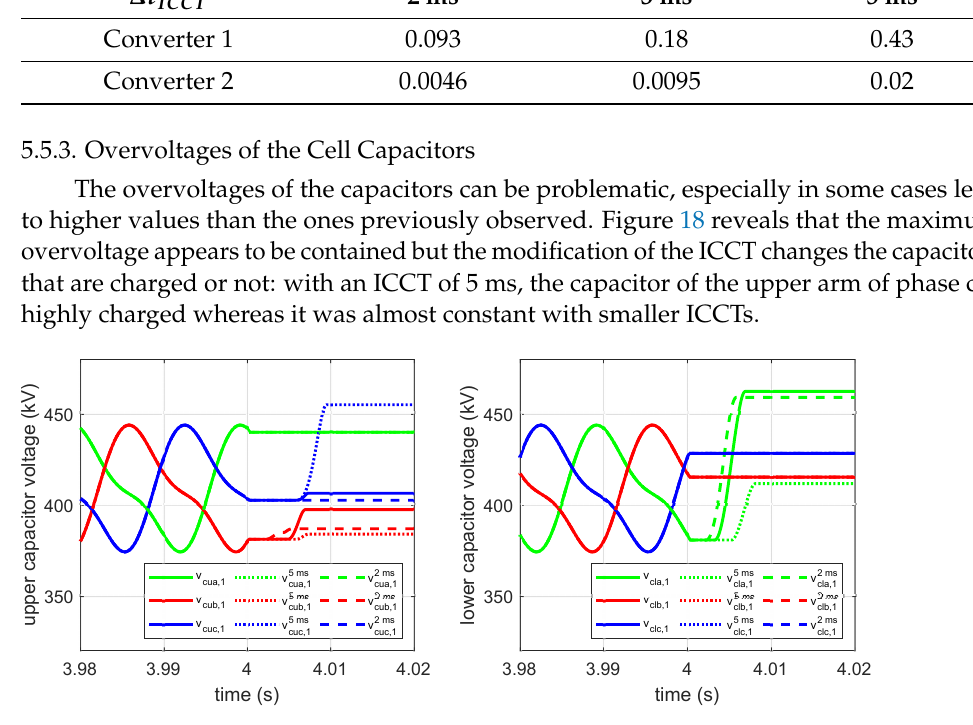
Figure 18. Capacitor voltages with different internal current-commutation times ∆ t ICCT , dashed line for ∆ t ICCT = 2 ms, solid line for ∆ t ICCT = 3 ms and dotted line for ∆ t ICCT = 5